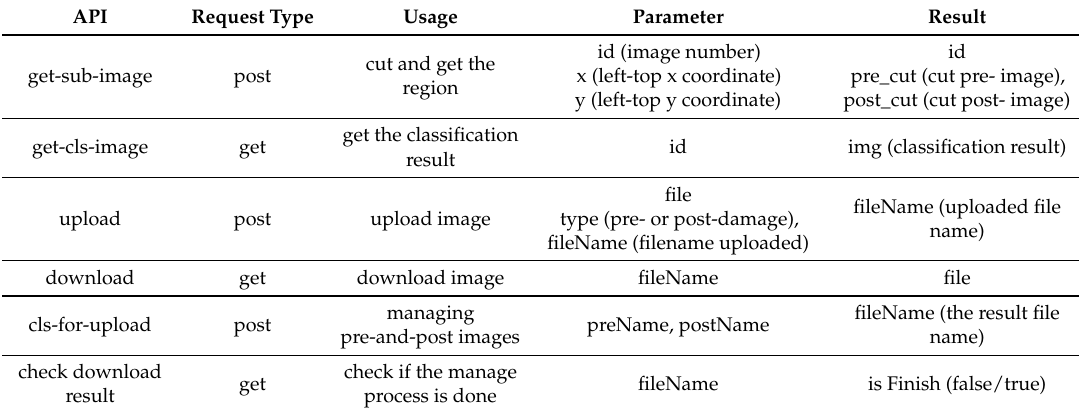
Table 5. API description